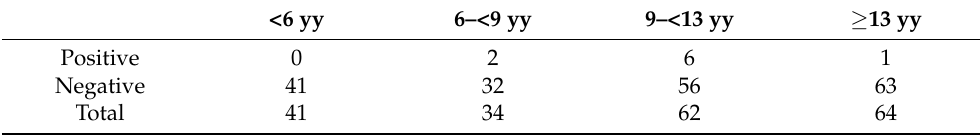
Table 4. EcPV9 genoprevalence in the different age groups. The age of two horses was unknown. <6